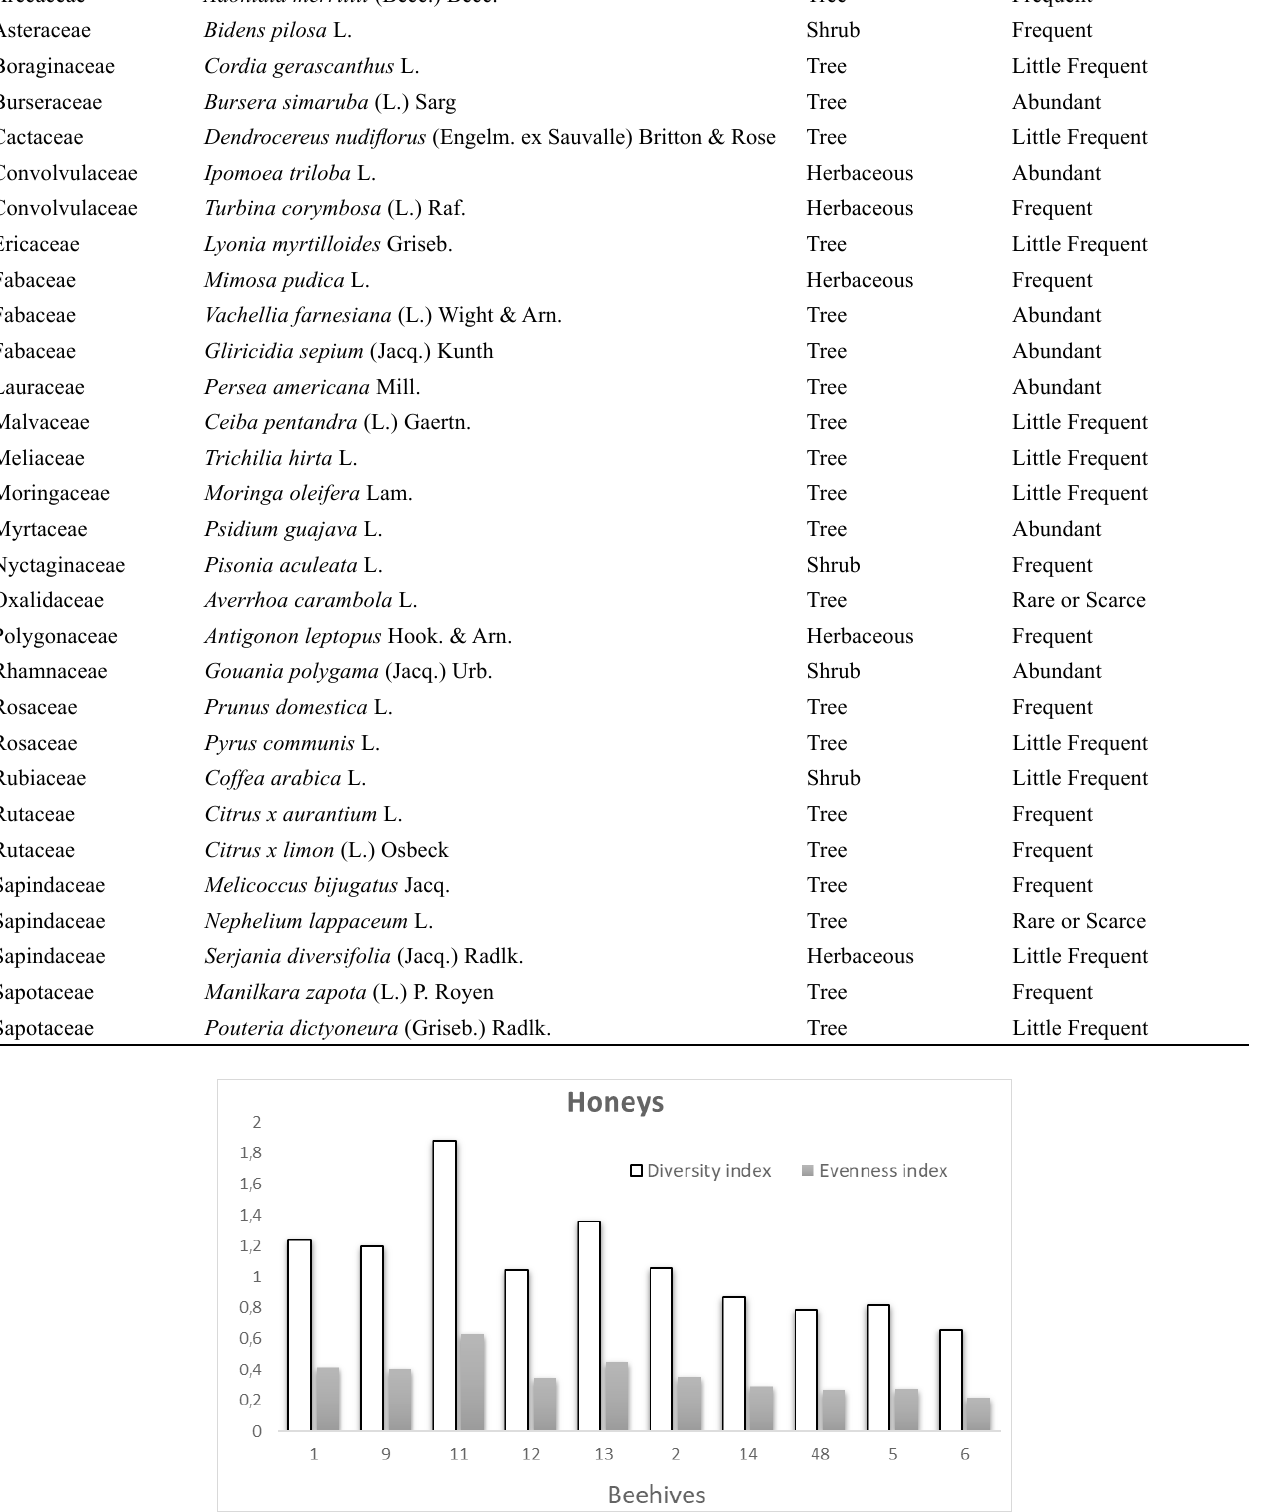
Fig 1 . Values obtained in the diversity (H´) and evenness (J´) indices of the Matanzas (1, 9, 11, 12, 13) and Mayabeque honeys (2, 14, 48, 5,